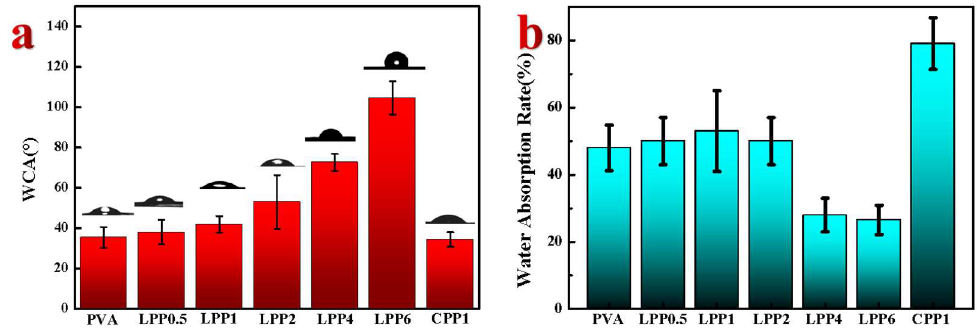
Figure 6. The water sensitivity of the films. ( a ) The water contact angle and digital photo of the film; ( b ) the water absorption rate of the films.